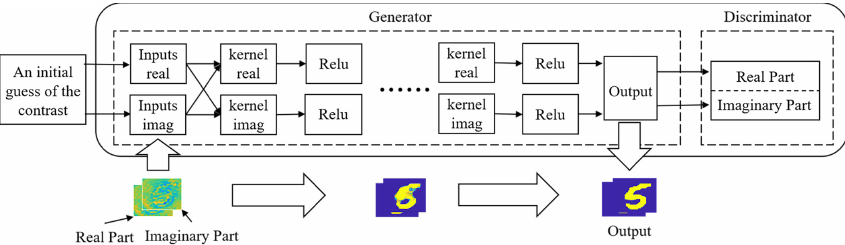
Figure 2. Overview of CVP2P network. The input data of the CVP2P comes from the back- propagation